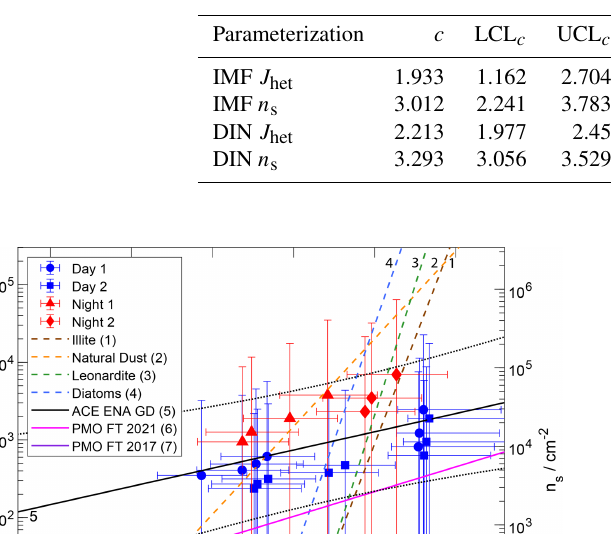
Table 4. Parameters for derivation of the immersion freezing (IMF) and deposition ice nucleation (DIN) heterogeneous ice nucleation rate coefficient ( J het ) and ice nucleation active site (INAS) density ( n s ) as a function of the water activity criterion, (cid:49)a w , according to log J het = c + m · (cid:49)a w and log n s = c + m · (cid:49)a w , are given. LCL and UCL represent lower and upper confidence levels at 95%, respectively, for the fit parameters. RMSE indicates the root mean square error of the fit.